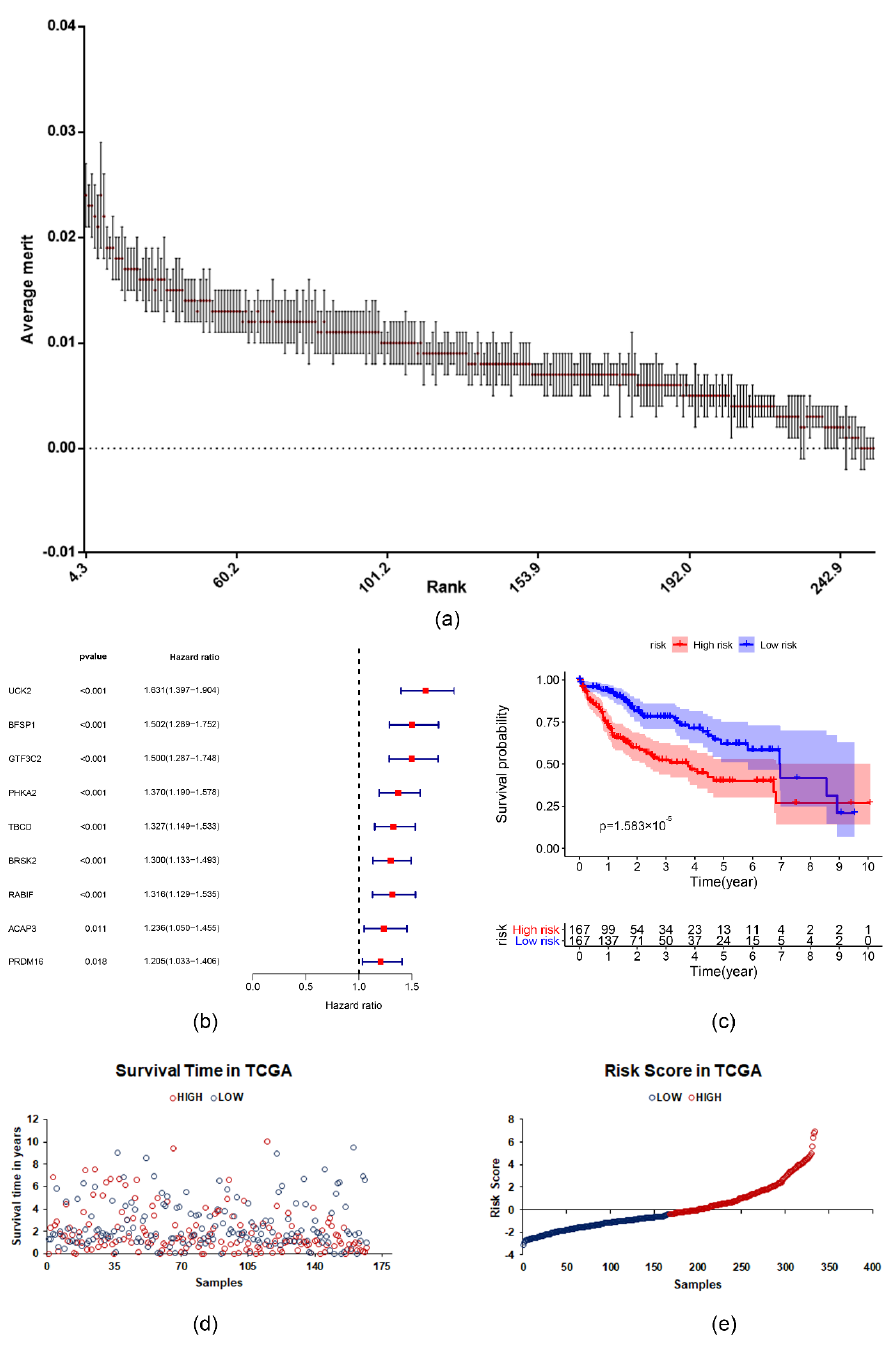
Figure 3. Features selection and Cox regression analysis were used to construct and analyze risk scores based on the survival-related m6A RNA methylation-related genes. ( a ) Rank of the survival- related m6A RNA methylation-related genes based on Relief algorithm. ( b ) The impact of important survival-related m6A RNA methylation-related genes on overall survival. ( c ) The Kaplan–Meier curve described the significant survival difference between the high-risk group and the low-risk group. ( d ) The distribution of survival time of samples in TCGA dataset. ( e ) The distribution of risk score of samples in TCGA